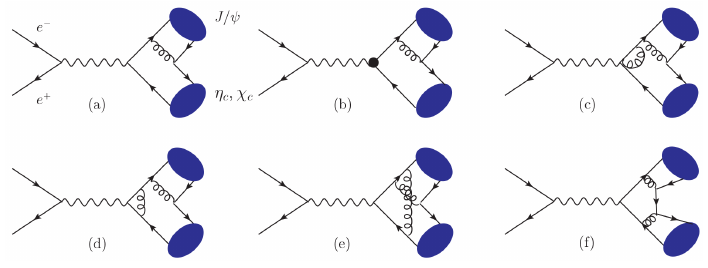
Figure 1 . Typical LO and NLO Feynman diagrams for e + e − → J/ψ + η c , χ cJ